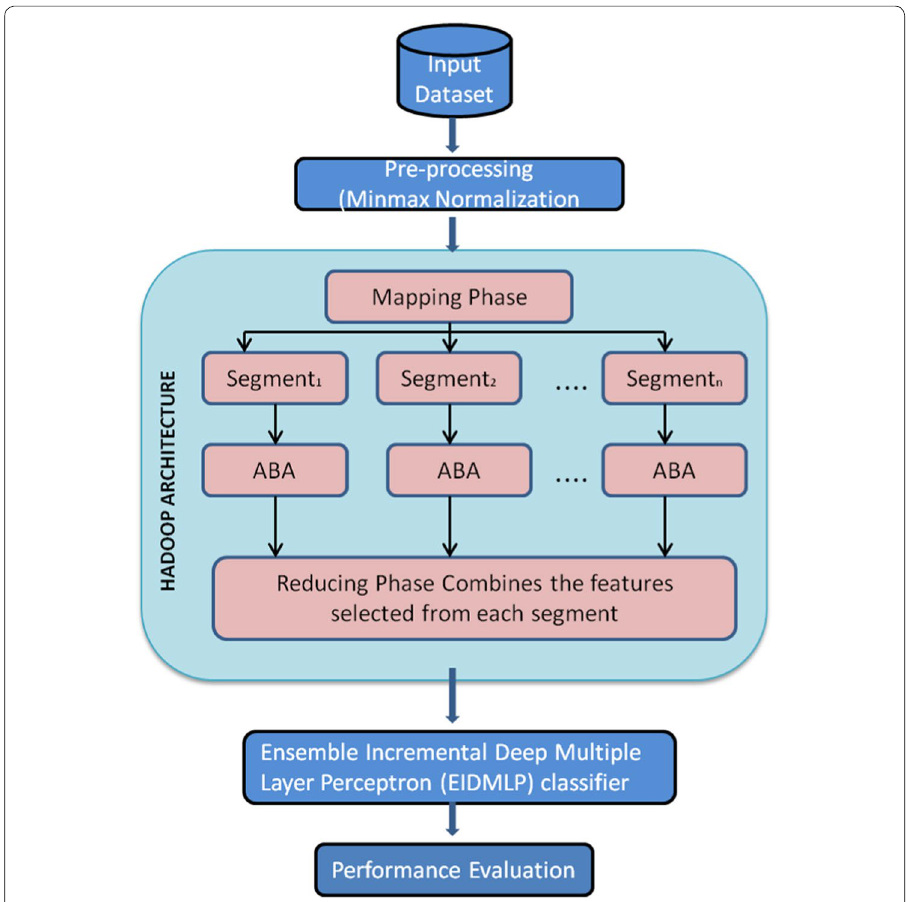
Fig. 2 OFS-ABA and EIDMLP algorithm